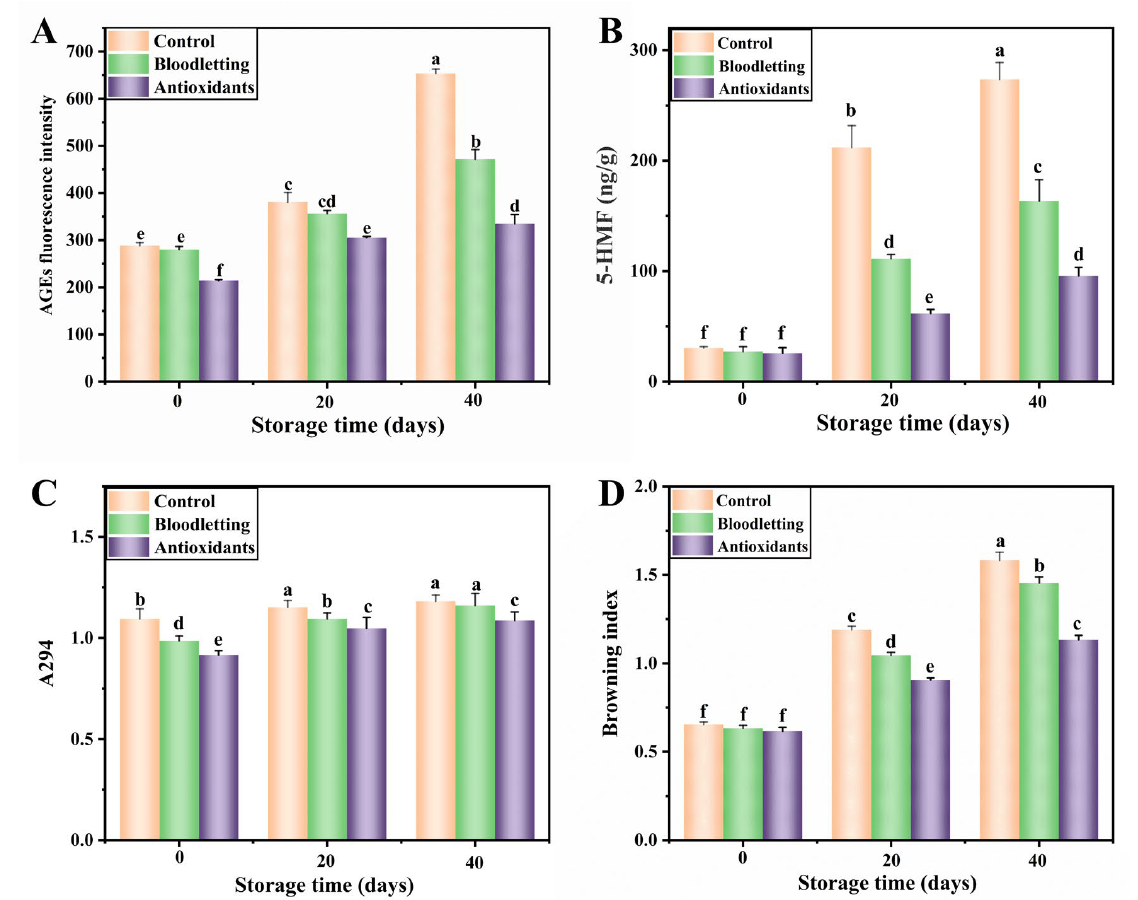
Figure 3. Changes in AGEs fluorescence intensity ( A ), 5-hydroxymethylfurfural content ( B ), Maillard intermediate product (A294) ( C ) and browning index ( D ) of abalone muscle during storage. Values of different groups with different lower-case letters are significantly different at p <